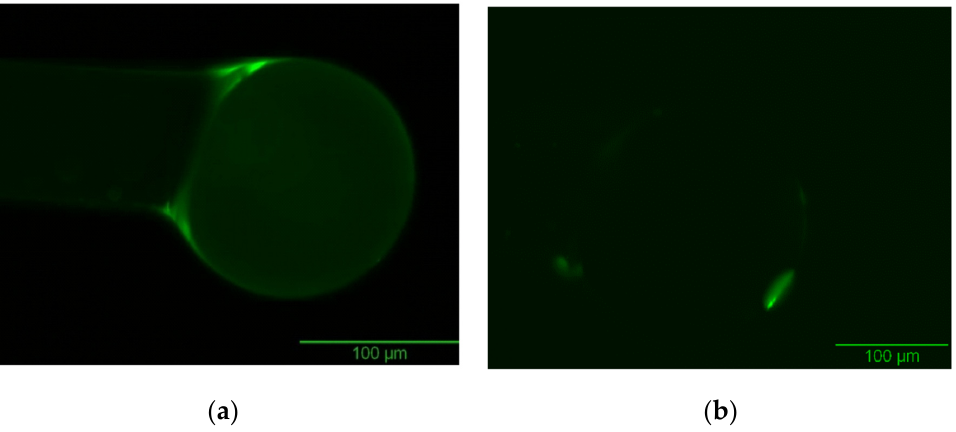
Figure 9. The result of normalized intensity values before and after the Oxygen plasma treatment taken from two Petri dishes, 22 and 23. Each Petri dish contains 5 spheres that are labeled with numbers for identification. A decrease in the normalized intensity is observed after the treatment suggesting that the template has been removed. Biosensors 2016 , 6 , 26